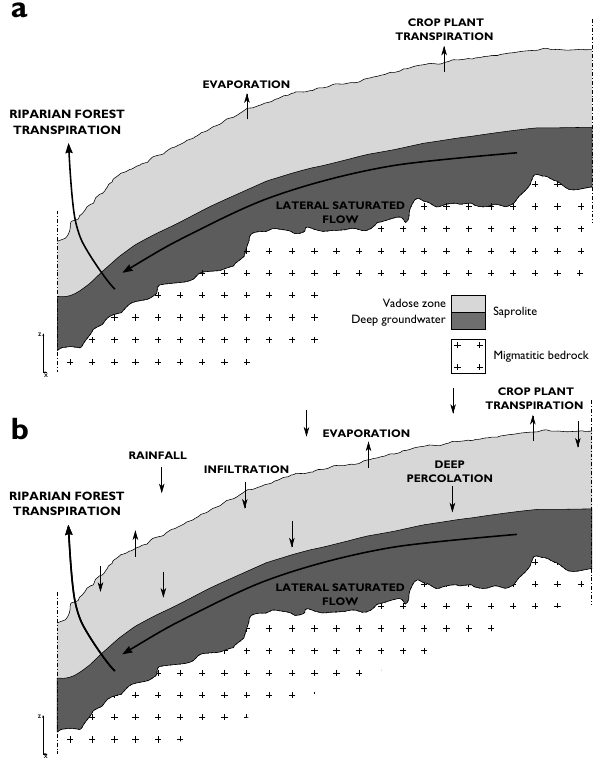
Fig. 11. Schematic hillslope hydrodynamics during the two con- trasted seasons: dry season (a) , wet season (b) . Vertical